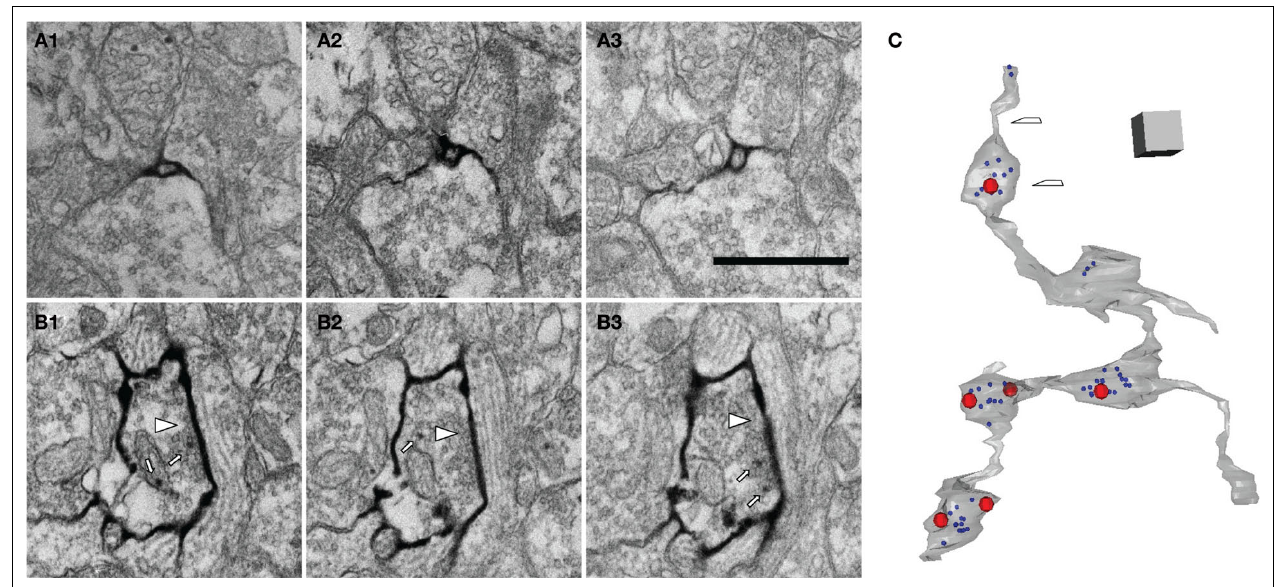
FIGURE 7 | mHRP labeling facilitates 3D reconstruction of identifi ed axons. (A –A ) Serial EM sections show the morphology of a fi ne axon shaft cut in cross 1 3 section. (B –B ) Serial EM sections show ultrastructural morphology of synaptic 1 3 contacts (white arrow heads). Note that mHRP-labeled synaptic vesicles are shown in the presynaptic terminal (white arrows). (C) 3D reconstruction of a